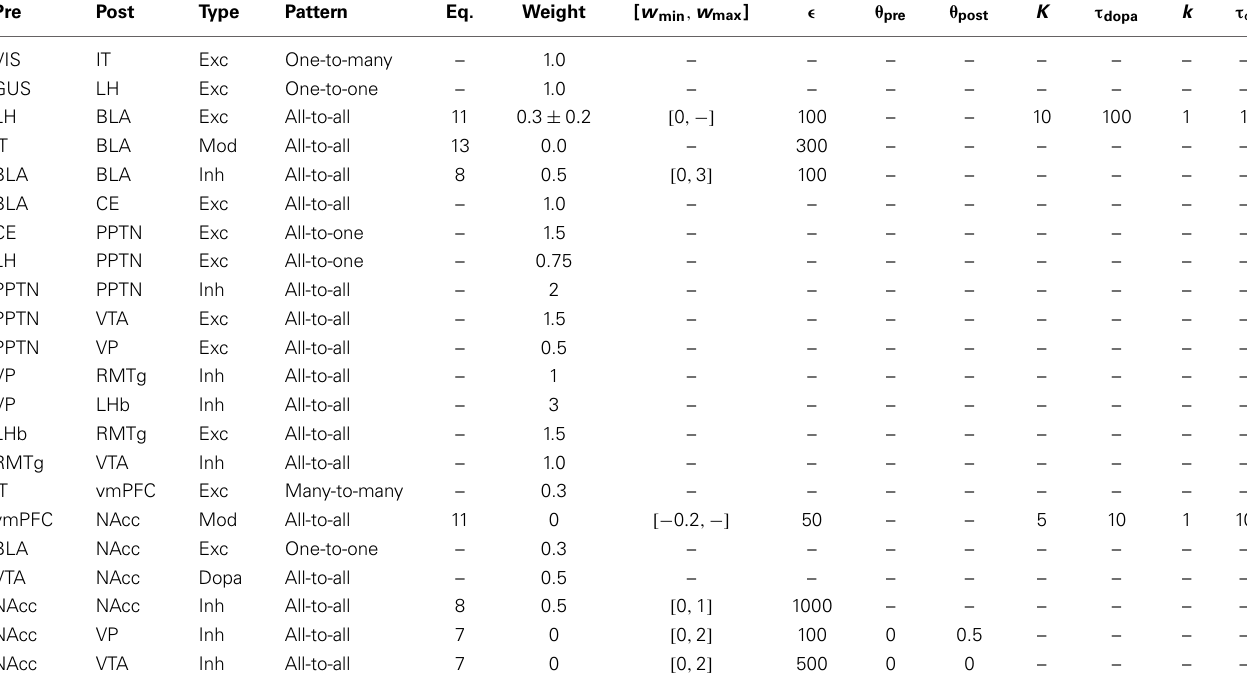
Table 2 | Parameters of the projections in the